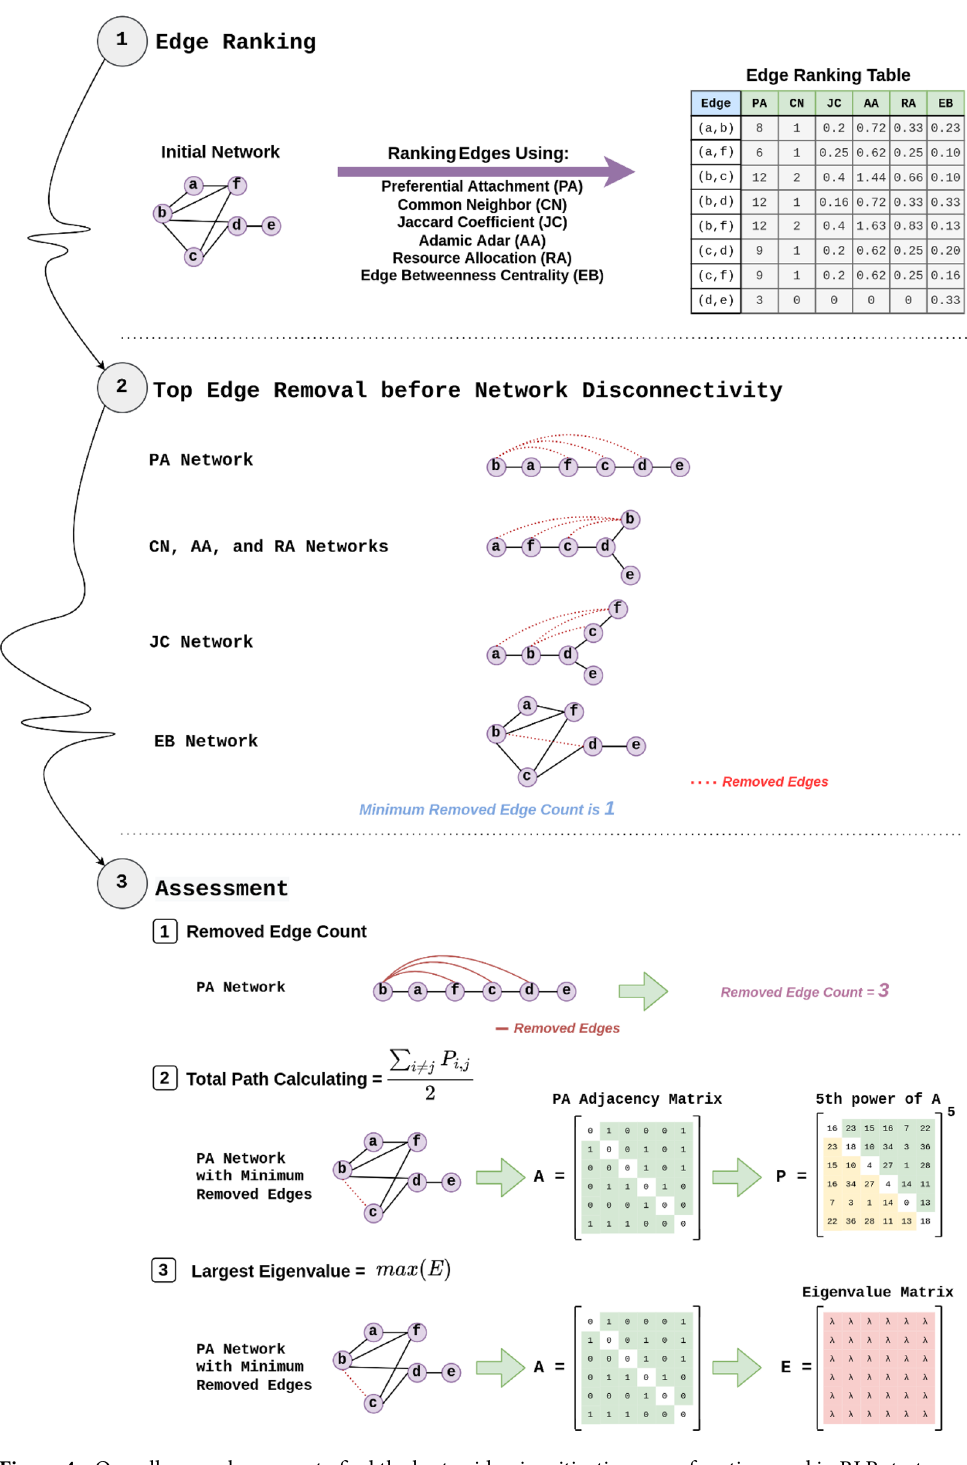
Figure 4. Overall research process to find the best epidemic mitigation score function used in RLP